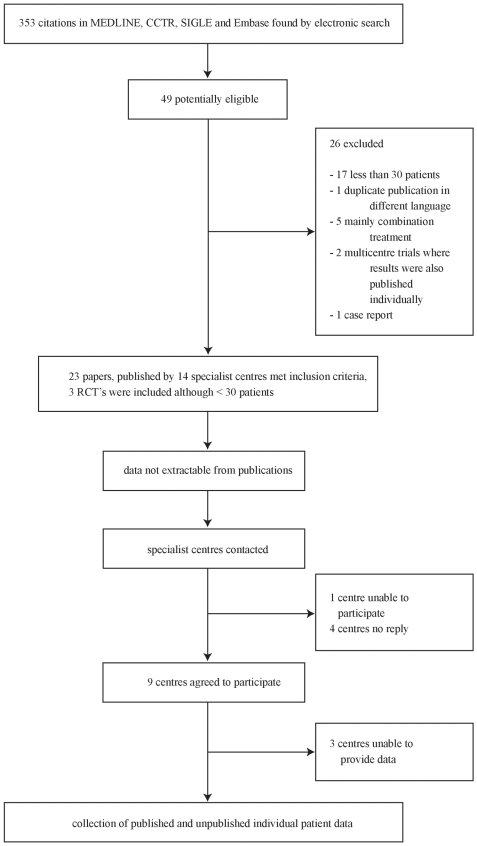
Flow diagram of searches, study selection, and specialist centre identification.